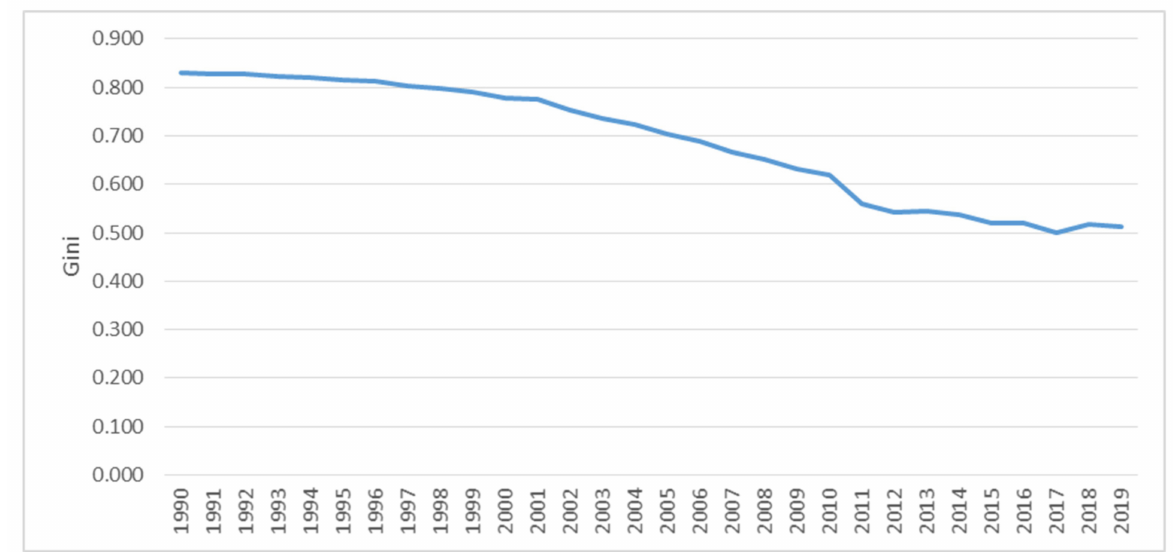
Figure 3. Changes in concentration of analyzed types of renewable sources in the production of electricity from renewable sources ( GEP_RES ) in the EU-27 in 1990–2019. Source: Own calculation based on Reference